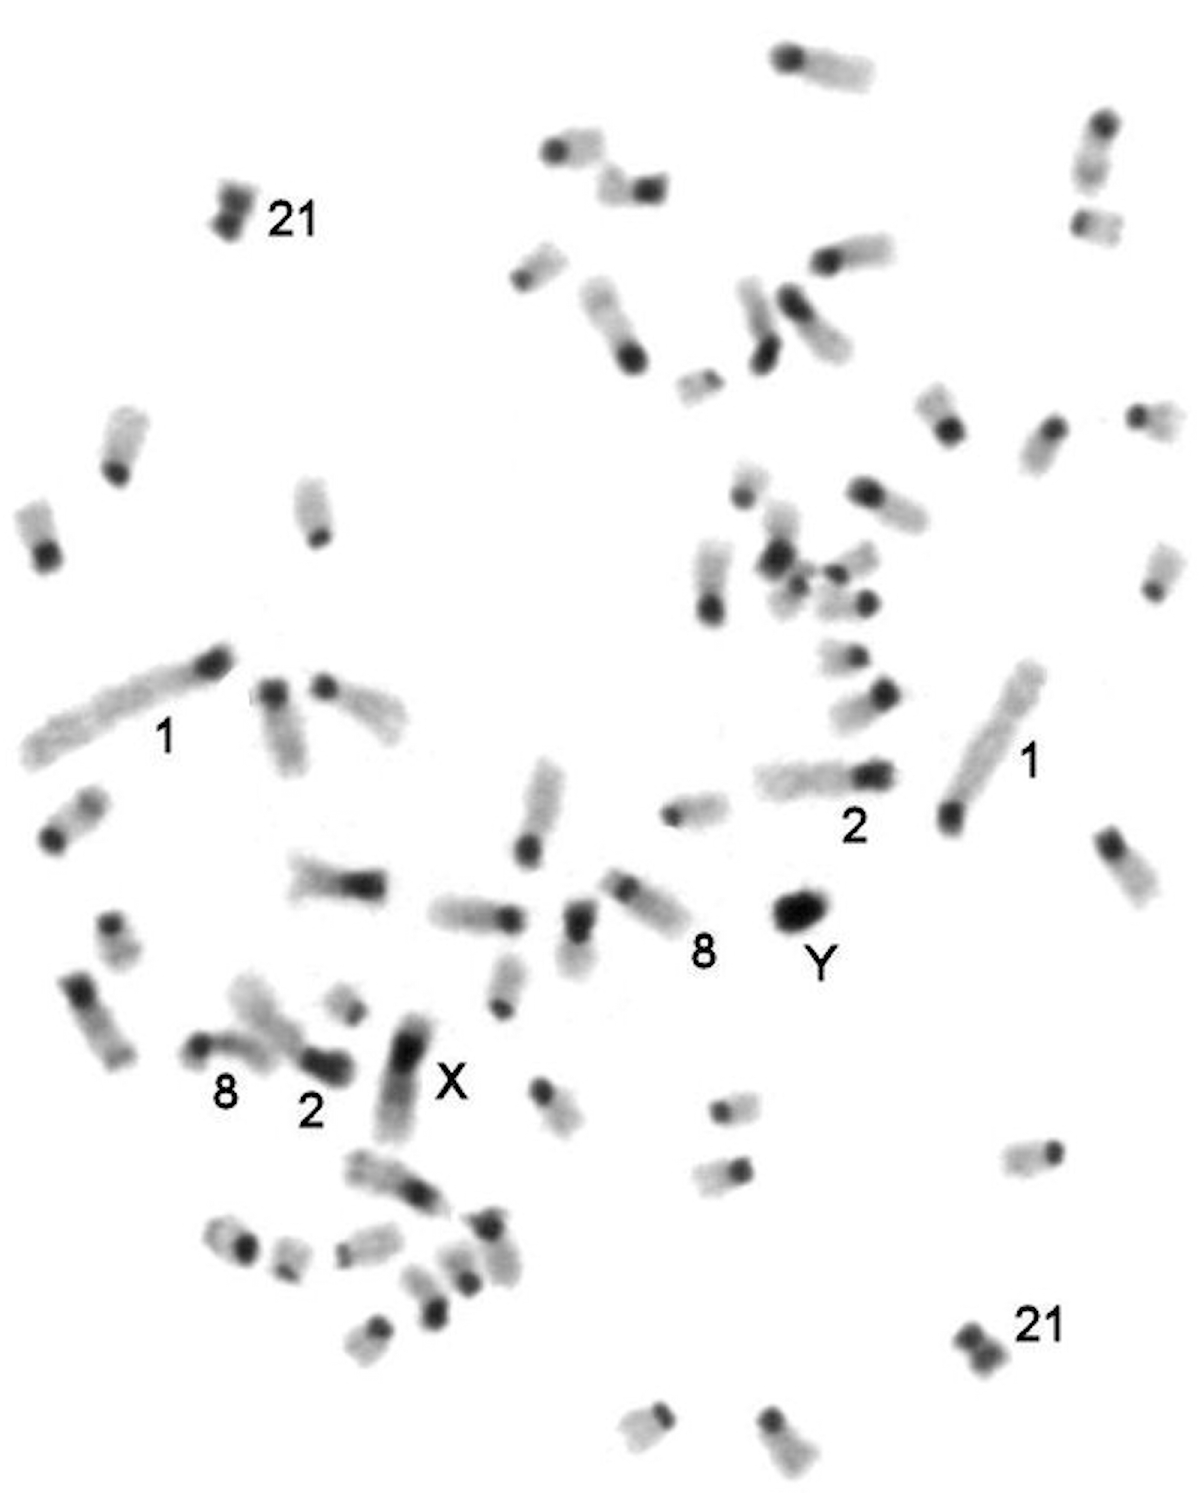
Fig 3. CBG-banding of C . porcellus metaphase chromosomes. Figures were constructed according to chromosome size and CBG-banding.